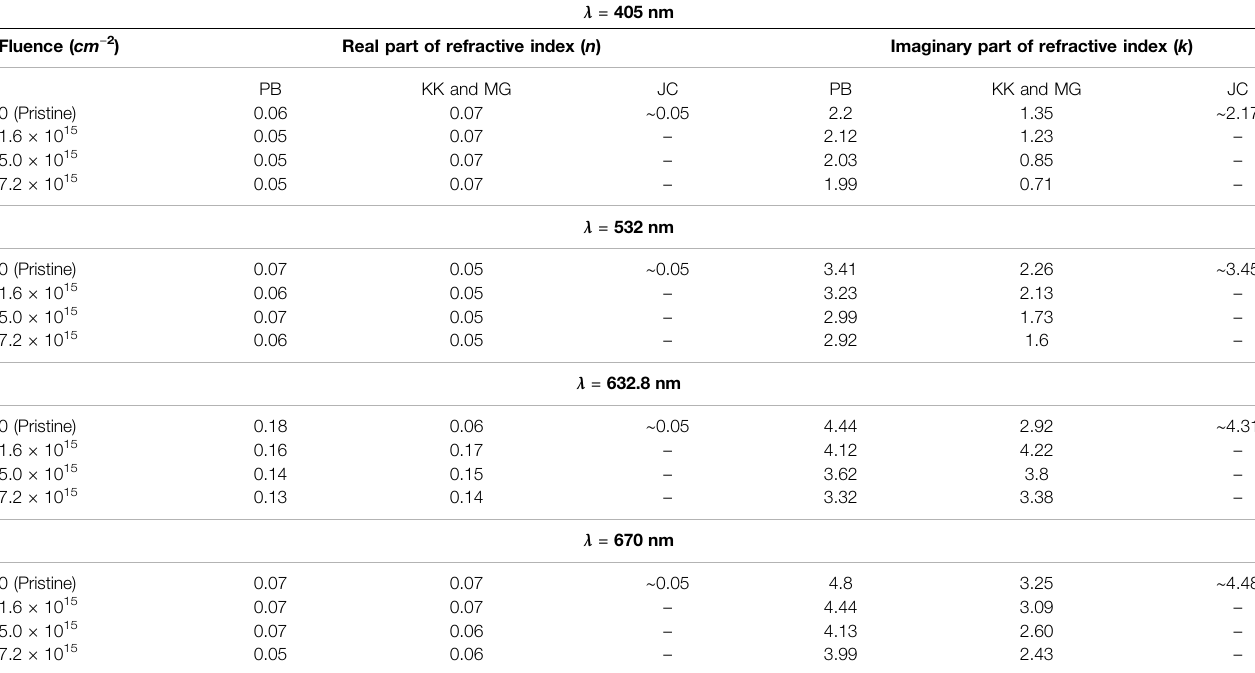
TABLE3| OpticalconstantsofsilverMTFwherePB:pseudo-Brewsterangletechnique,KK:Kramers-Kronigtechnique,MG:Maxwell-Garnetttechnique,JC:Johnsonand Christy [6] data.